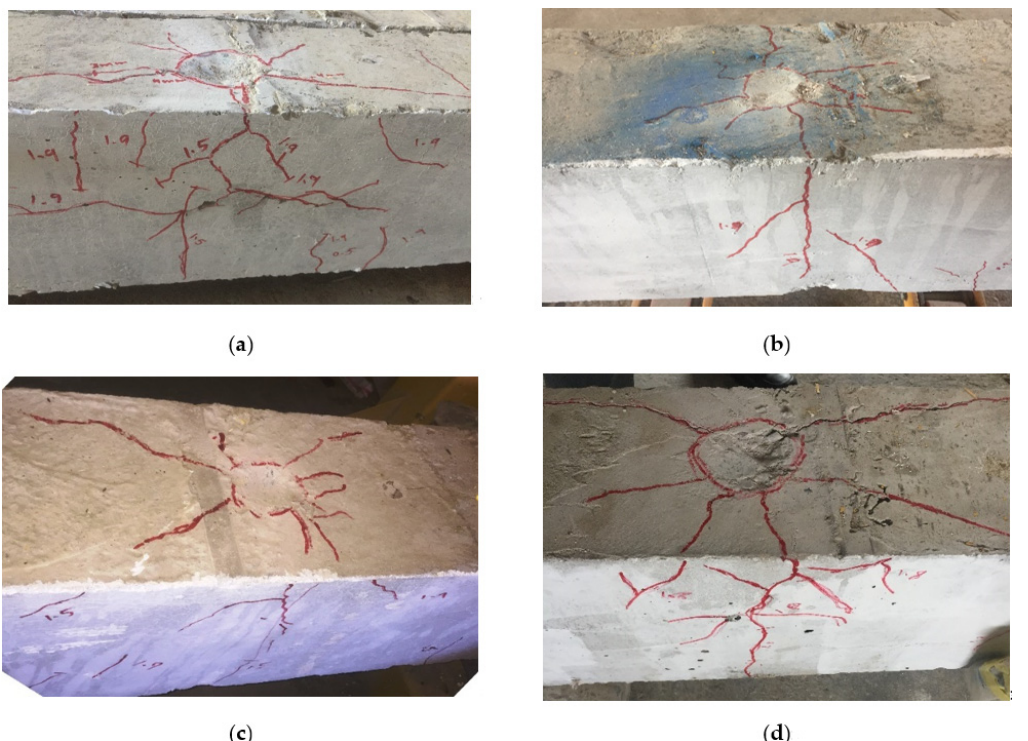
Figure 6. Local damage at the impact zone of the impact tested specimens: ( a ) NR ‐ I; ( b ) CG ‐ I; ( c ) CGC ‐ I; ( d ) CS ‐ I.